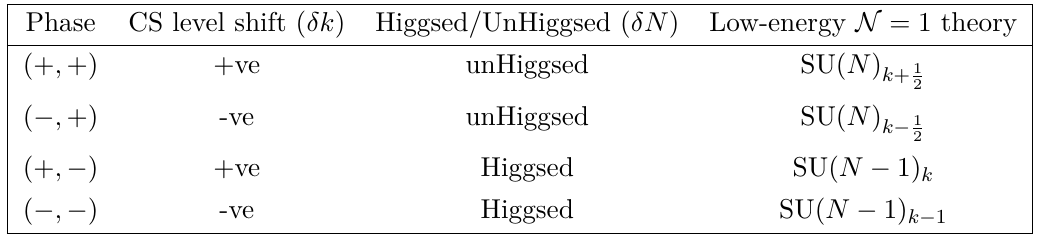
Table 1. Possible phases in the